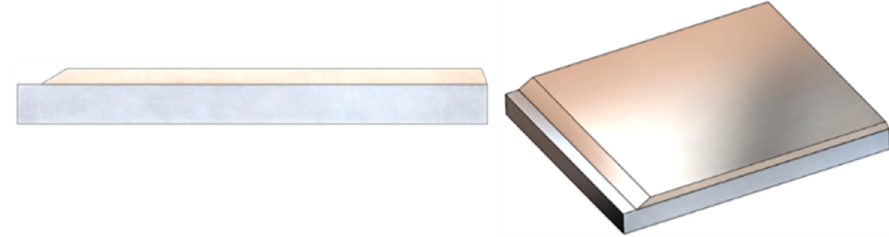
Figure 3. Cross section and isometric rendering of cold-sprayed coating on Al 6061-T6 plate.